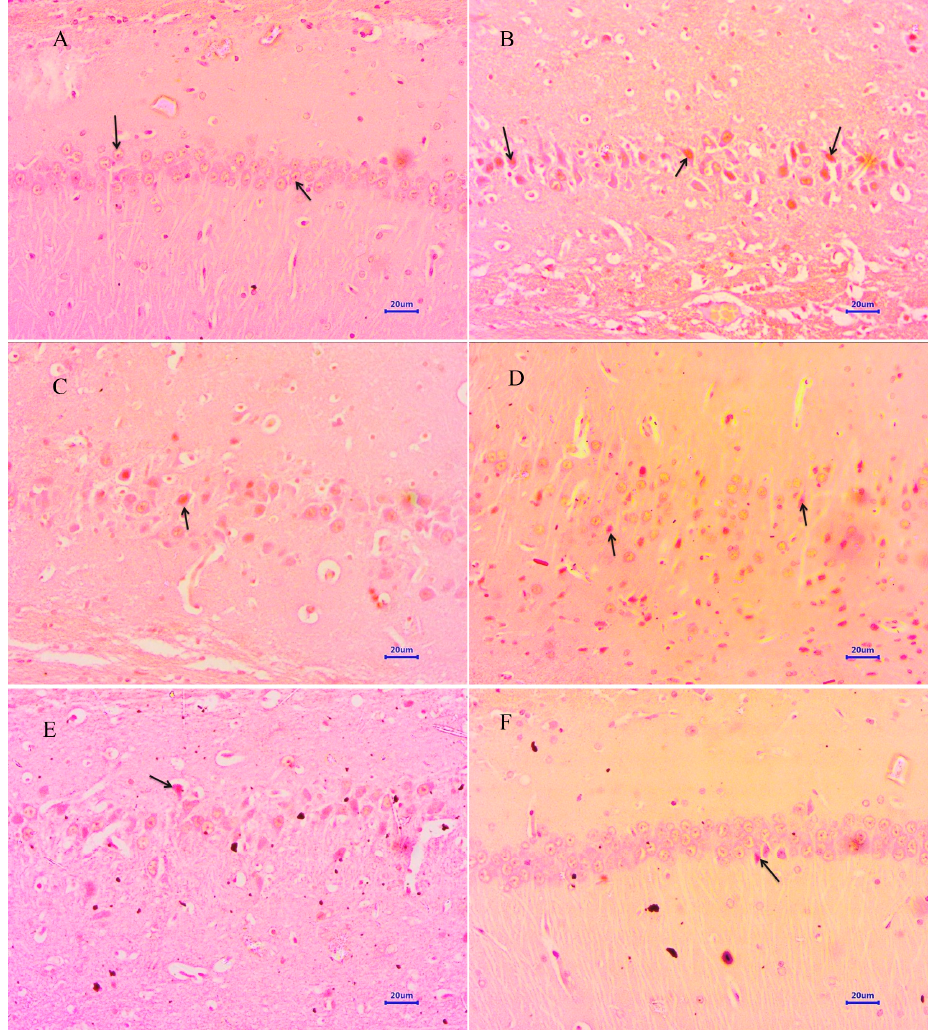
Figure 8. Effect of A β (1–42), baicalein and baicalein with memantine on Congo-red-stained hippocam- pus (400×). ( A ) Normal control: displaying normal histology, normal neuronal cells in hippocampus (arrow). ( B ) Disease control: displaying multifocal moderate to severe deposition of β -amyloid (ar- row) in hippocampus. ( C ) Memantine 20 mg/kg: displaying multifocal moderate deposition of β - amyloid (arrow) in hippocampus. ( D ) Baicalein (10 mg/kg): displaying multifocal mild to moderate deposition of β -amyloid deposition (arrow) in hippocampus. ( E ) Memantine + Baicalein (20 + 5 mg/kg): displaying multifocal mild deposition of β -amyloid (arrow) in hippocampus. ( F ) Meman- tine + Baicalein (20 + 10 mg/kg): displaying focal mild deposition of β -amyloid (arrow) in hippocam- pus.